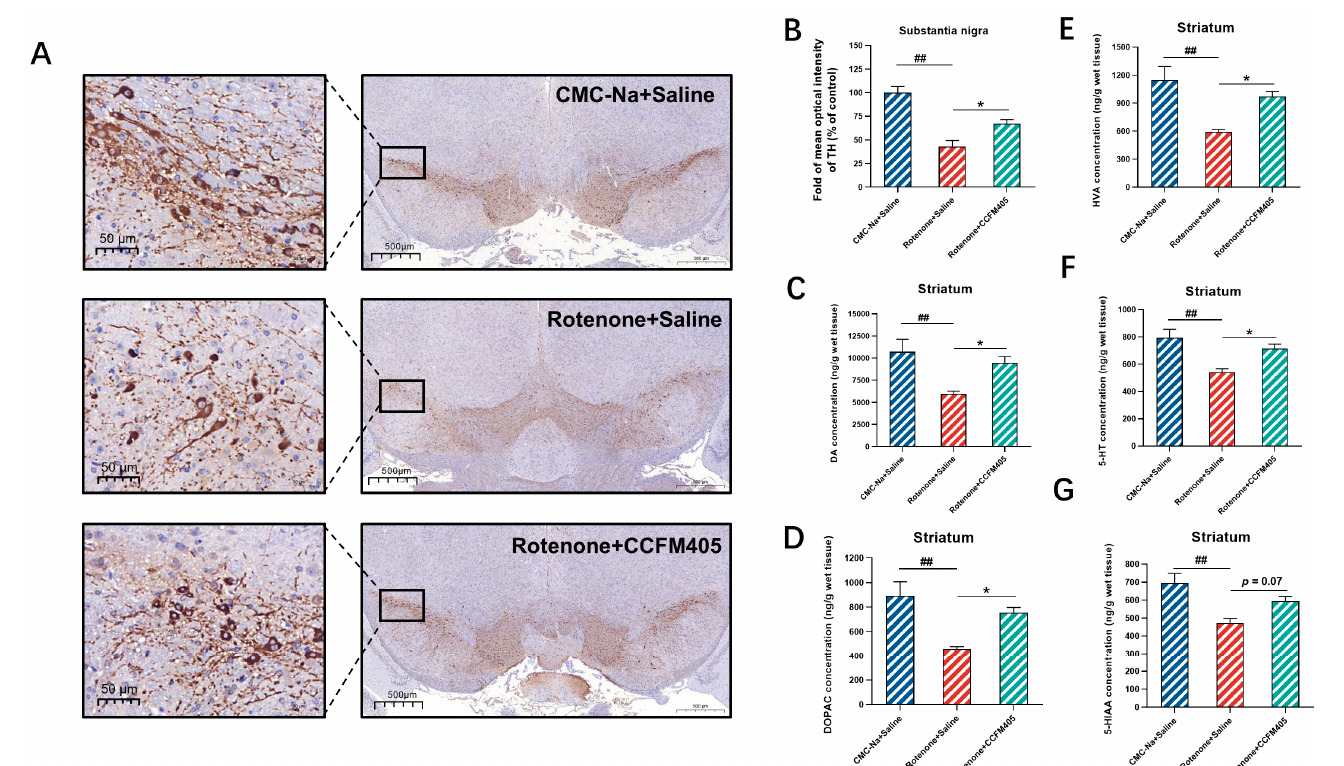
Figure 3 . Effects of L. plantarum CCFM405 on dopaminergic neurons and neurotransmitters in the striatum of rotenone-challenged PD mice. ( A ) Representative images of TH immunohistochemistry in the left and right substantia nigra. Scale (left: 50 µ m right: 500 µ m) ( n = 3/group); ( B ) quantitative evaluation of average optical density (OD) of TH positive area in the left and right substantia nigra ( n = 3/group); The concentrations of neurotransmitters in the unilateral striatu ( C ) DA, dopamine; ( D ) DOPAC, 3,4-dihydroxyphenylacetic acid; ( E ) HVA, homovanillic acid; ( F ) 5- HT, 5-hydroxytryptamine; ( G ) 5-HIAA, 5-hydroxyindoleacetic acid. n = 8/group. Data are means with SEM. ## p < 0.01 signs Rotenone + Saline group vs. CMC-Na + Saline group; * p < 0.05 signs Rotenone+CCFM405 group vs. Rotenone+Saline grup.